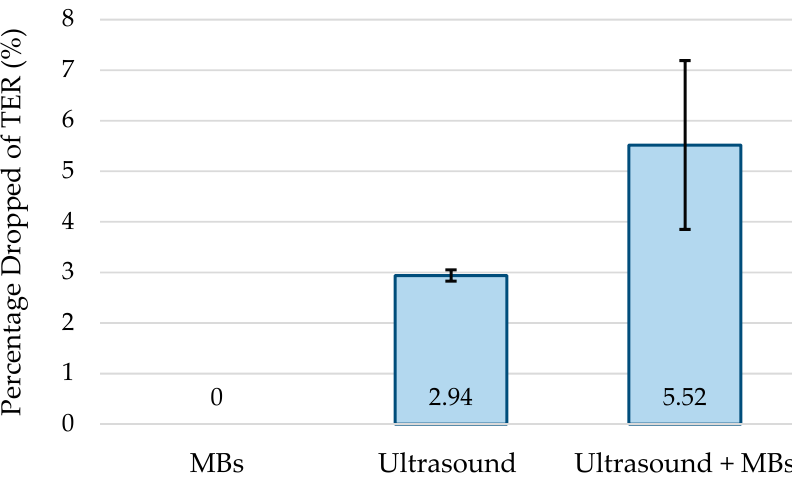
Figure 10. Effect of TER on small bowel model. MB-only samples were unaffected. Ultrasound-only samples had an average drop of 2.94% from initial TER. Samples exposed to ultrasound with MBs present had an average drop of 5.52% from the starting value.